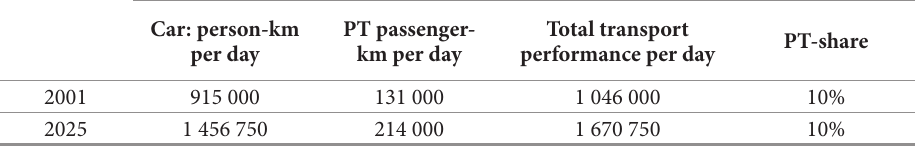
Table 2. Development of the transport performance in Liechtenstein 2001– 2025 (Ingenieurgemeinschaft EGB-Guha-Konrad